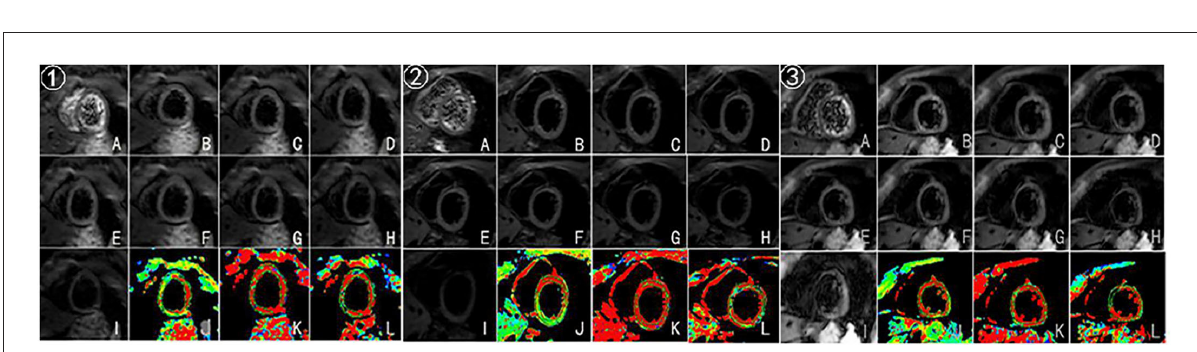
FIGURE3 (A–I) Original images of IVIM at the left ventricular short-axis view (corresponding to b = 0, 20, 50, 80,100, 120, 200, 300, and 500 s/mm 2 , respectively). (J–L) Pseudocolor images were produced using the bi-exponential mode of the IVIM imaging system (corresponding to ADC slow , ADC fast , and f values, respectively). ‹ , › , fi represent IVIM images after the third, fifth, and eighth chemotherapy sessions.